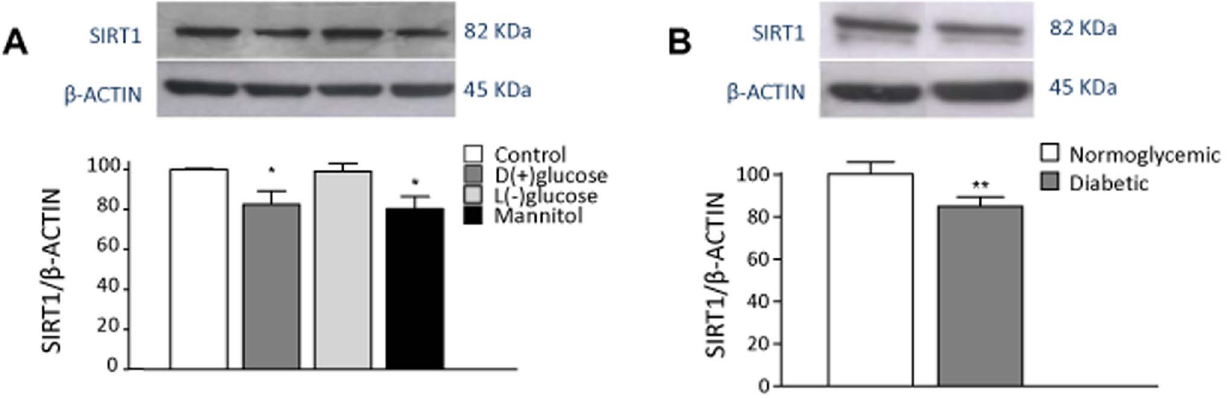
Figure 3. Effect of diabetes and high glucose on SIRT1 protein. ( A ) VSMCs from normoglycemic and STZ-diabetic rats were incubated in 10% FBS culture medium for 24 h. ( B ) VSMCs from normoglycemic rats were incubated in 10% FBS culture medium (control) for 24 h in the presence or absence of D-( + )-glucose, L-( 2 )-glucose and the osmotic regulator mannitol (all 22.2 mM). SIRT1 is shown as% expression, where 100% refers to the amount detected in untreated VSMCs from normoglycemic rats. Representative Western blot experiments are shown above bars. Values are mean 6 SEM (n=6–12). * p , 0.05 vs control.